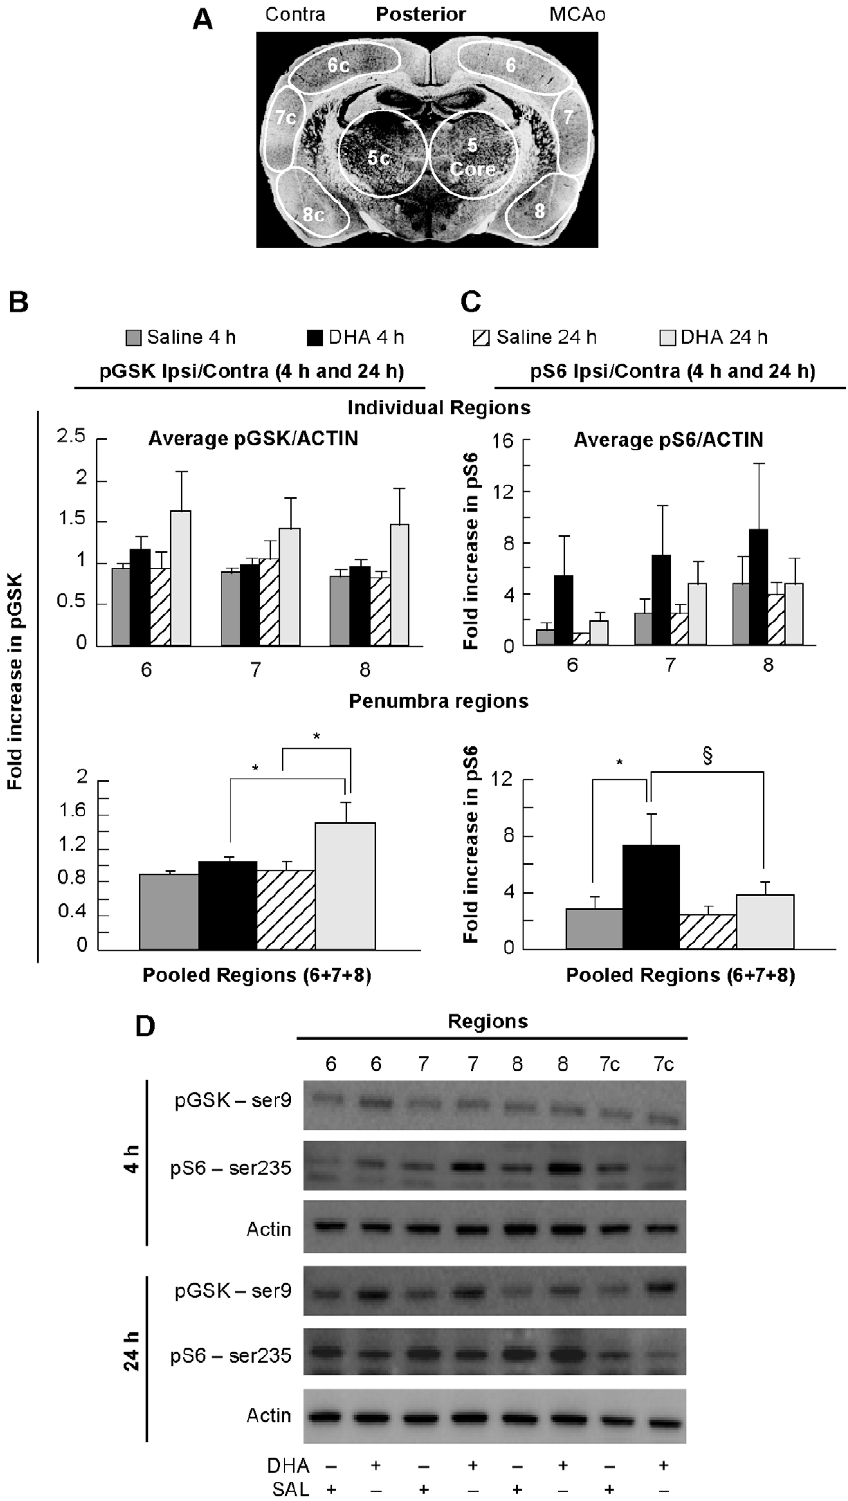
Figure 4. GSK and S6 phosphorylation in young rats. Panel A: Schematic coronal brain diagram (bregma level 2 1.8 mm) showing the locations of regions for western blot analysis, conducted at 4 and 24 h after onset of stroke. Individual regions of the penumbra or pooled penumbral regions were analyzed. Panel B: Treatment with DHA results in an increase of phosphorylation at pGSK (ser 9) at 24 h when compared to saline at 24 h and DHA at 4 h. Panel C: Treatment with DHA results in an increase of phosphorylation at pS6 (ser 235) when compared to Saline at 4 h. Panel D: Representative Western blots of GSK and S6 trials. Data are mean 6 SEM. * and 1 indicate significant differences between groups (p , 0.05; repeated measures ANOVA followed by Bonferroni tests).